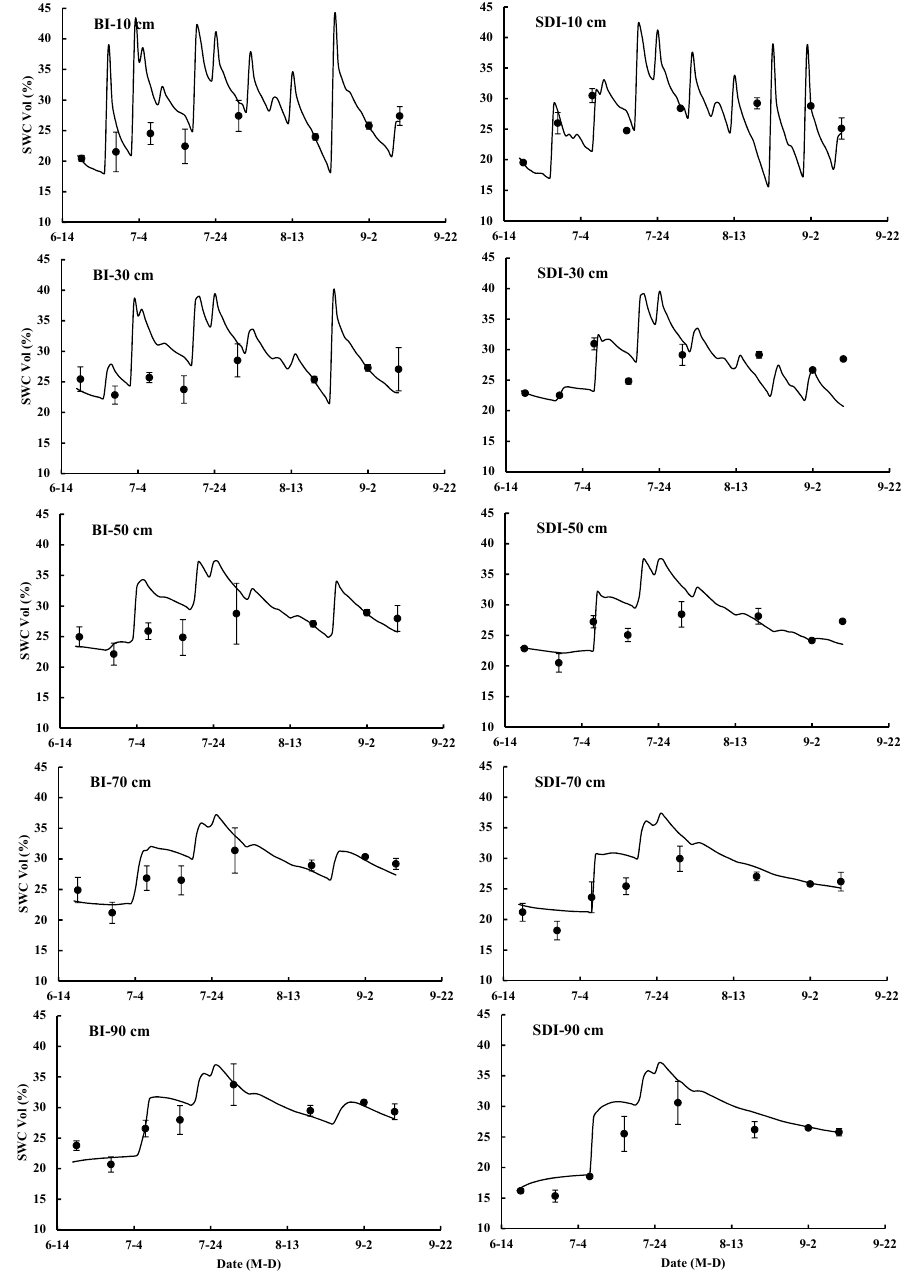
Figure 11. Simulated SWCs (lines) and measured SWCs (dots) at various depths in the row of cotton plants in 2013. Abbreviations: BI, border irrigation; SDI, surface drip irrigation; and SWC, soil water content. The vertical bars represent the standard errors of the means.